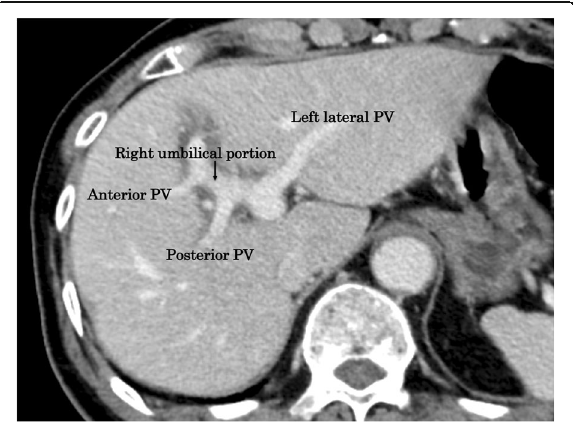
Fig. 2 Abdominal contrast-enhanced computed tomography findings. The intrahepatic portal vein formed the right umbilical portion (black arrow)